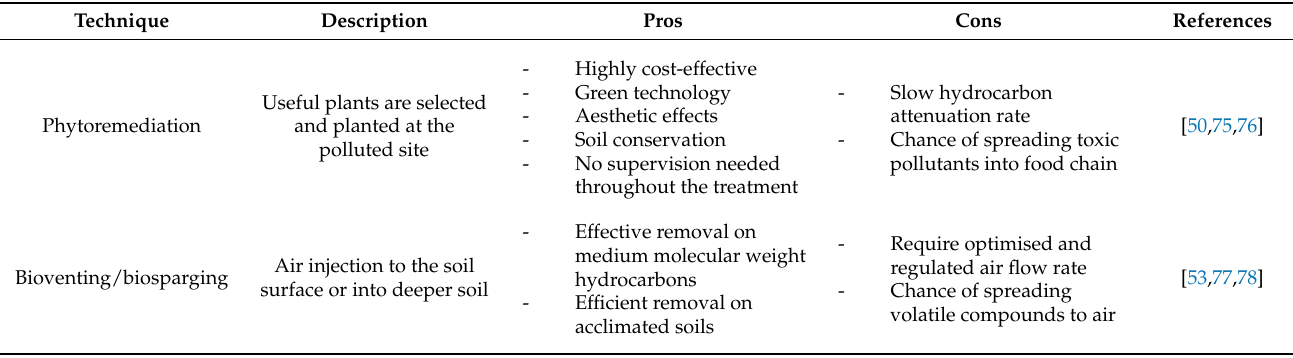
Figure 3. Potential hydrocarbon bioremediation approaches on contaminated soils under cold environments. Table 3. Hydrocarbon bioremediation techniques under cold